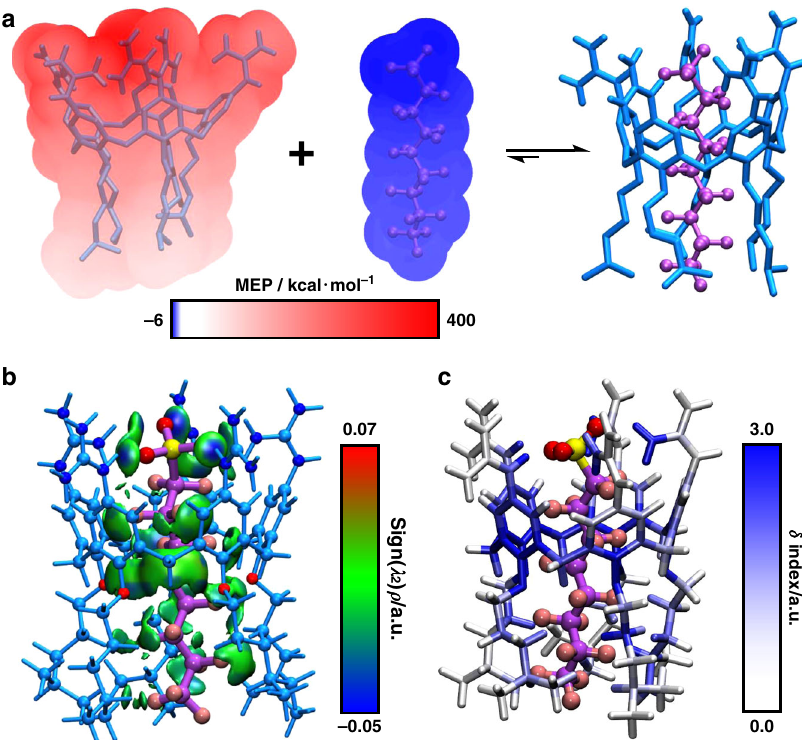
Fig. 2 Binding geometry of GC5A-6C and PFOS. a The optimized binding geometry of the GC5A-6C (cid:129) PFOS complex (right) at the B3LYP-D3/6 – 31G(d)/ SMD(water) level of theory and the MEP-mapped molecular van der Waals surfaces of GC5A-6C (left) and PFOS (middle). b δ g inter = 0.01 a.u. isosurfaces colored by the sign of ( λ 2 ) ρ for the GC5A-6C (cid:129) PFOS complex (the meaning of δ g inter and sign( λ 2 ) ρ were in ref. 58 ). Blue indicates strong attraction, while red indicates strong repulsion. c The atoms of GC5A-6C colored according to their contributions to the binding with PFOS. White indicates no contribution to the complexation, and blue indicates the largest relative